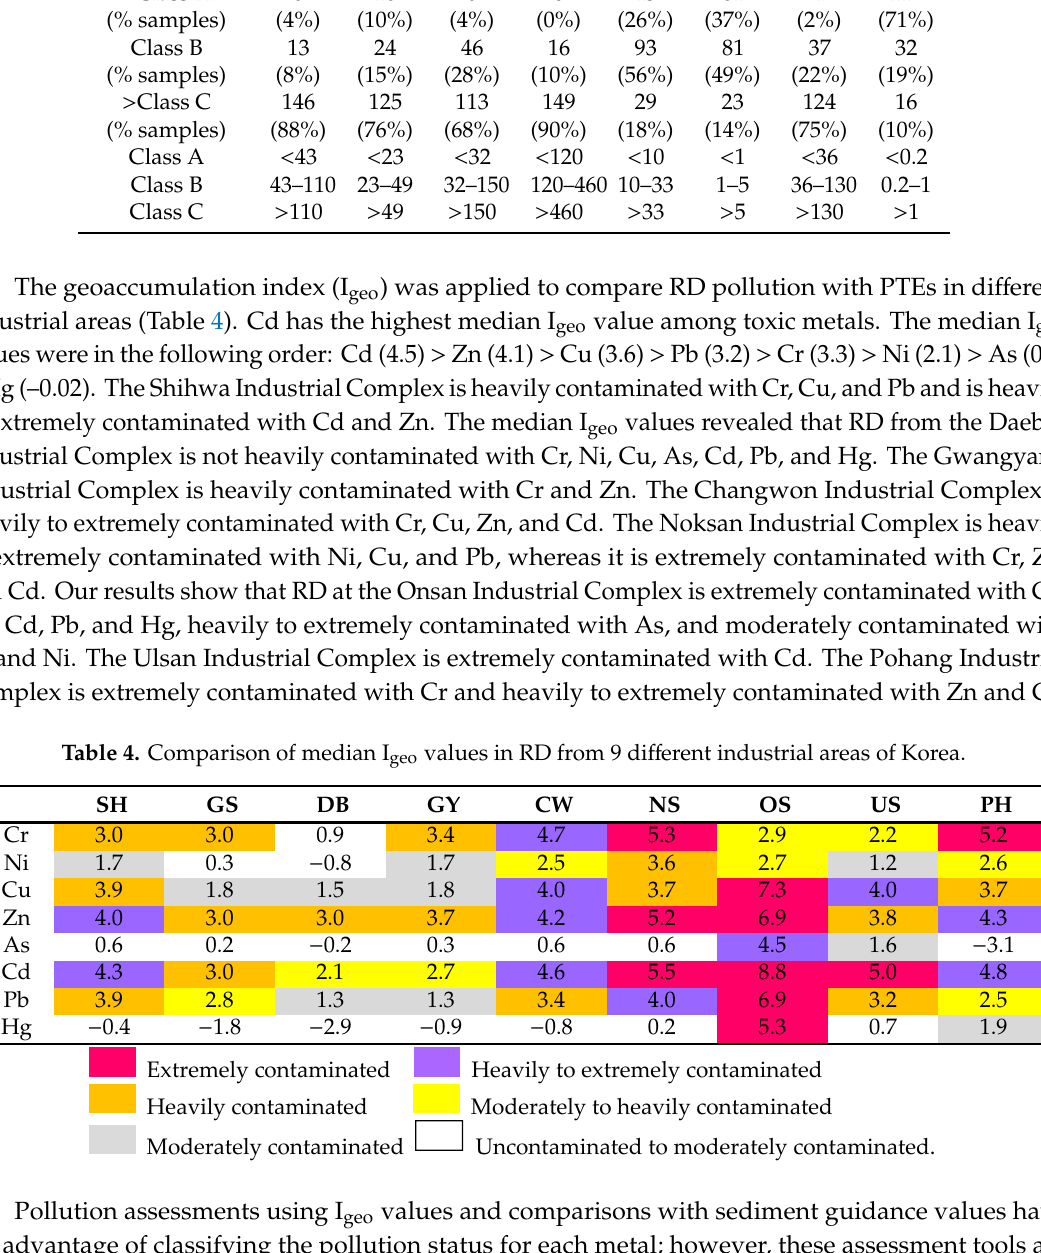
Table 3. Comparison of sediment criteria and percent exceedance samples (in parentheses) using freshwater sediment guidance values (class A, B, and C) in all RD samples ( N = 165) of this study. Cr Ni